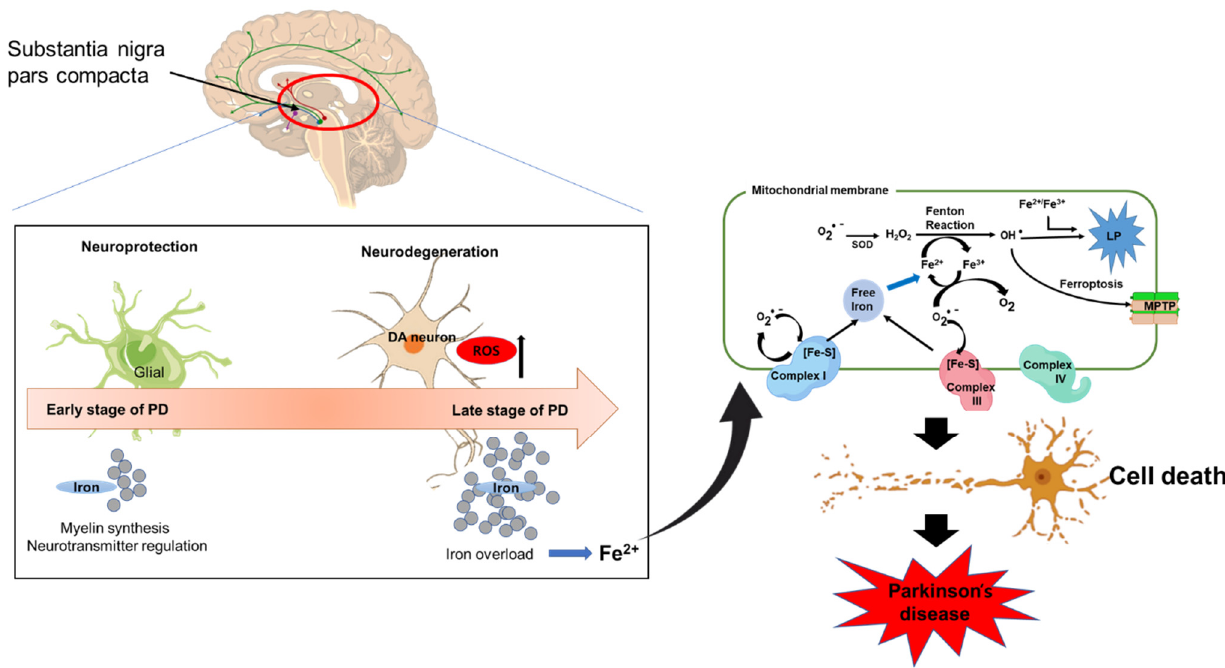
Figure 1. Role of Fe in mitochondrial dysfunction and neuronal death leading to PD. Increased levels of Fe may cause neurodegeneration through the production of large amounts of reactive oxygen species (ROS) via the Fenton reaction. Fe can induce mitochondrial oxidative stress through interactions with different ROS. Free Fe can be released from mitochondrial Fe-sulfur clusters in complexes I and III upon interacting with ROS. The redox pair Fe 2+ -Fe 3+ can directly stimulate lipid peroxidation (LP), which is an indicator of oxidative stress and contributes to mitochondrial dysfunction via mitochondrial permeability transition pore (mPTP) formation, thus leading to neural damage and the induction of PD.